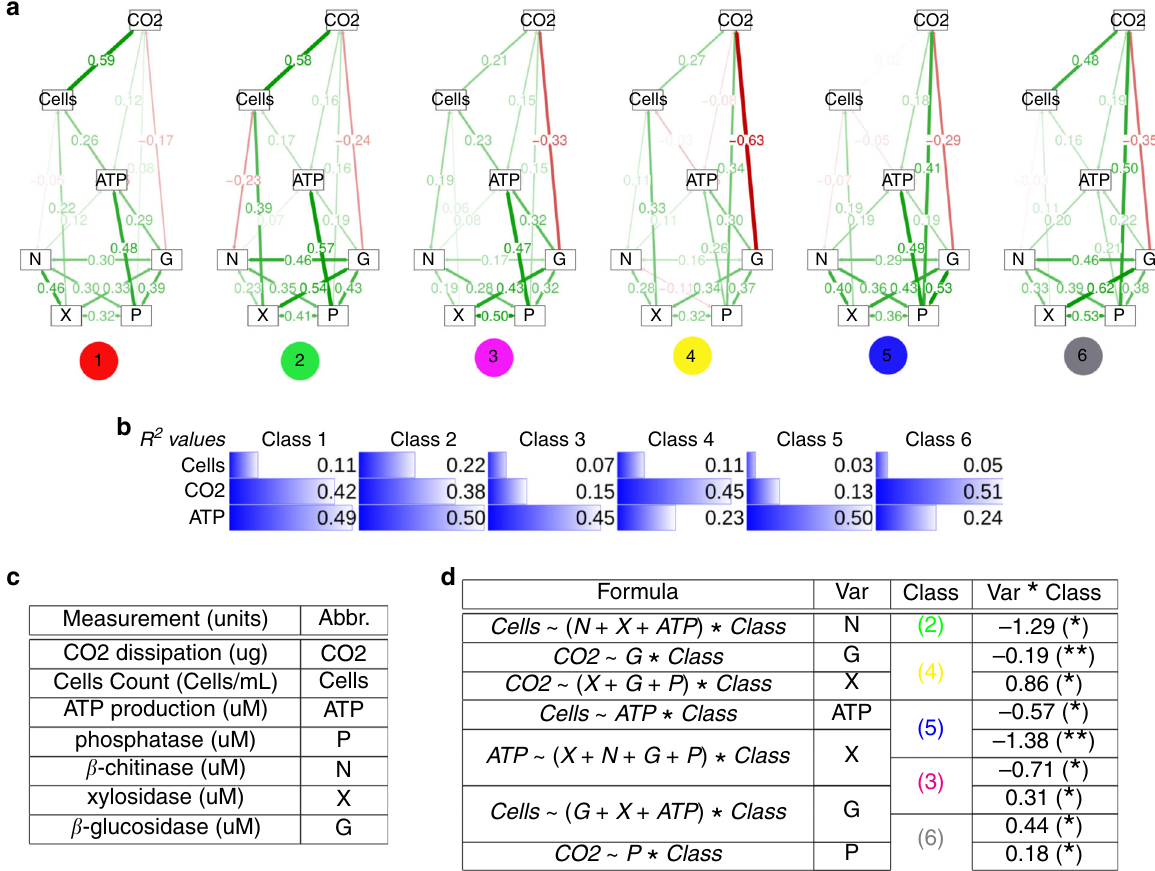
Fig. 3 Functional capacity of the community classes. a Diagrams of the fi nal SEMs. The standarized coef fi cients for each of the six classes are shown on the corresponding pathway. b R 2 values for the three endogenous variables in the SEM model. c Experimental measurements used in this study and their abbreviations. Four independent replicates of each function were measured and then averaged to conduct the analysis. d Causal analysis of the in fl uence of the exogenous variable (Var) for each SEM pathway (determined by the response variable and Var in Formula) when the identity of the classes is included as a factor. Confounding factors involved in the pathway are also included (remainder variables in Formula). The column Class re fl ects the class identity of any signi fi cant coef fi cient found in the interaction terms of the regression with its value shown in the column Var * Class (signi fi cance code: * p value < 0.01, ** p value <